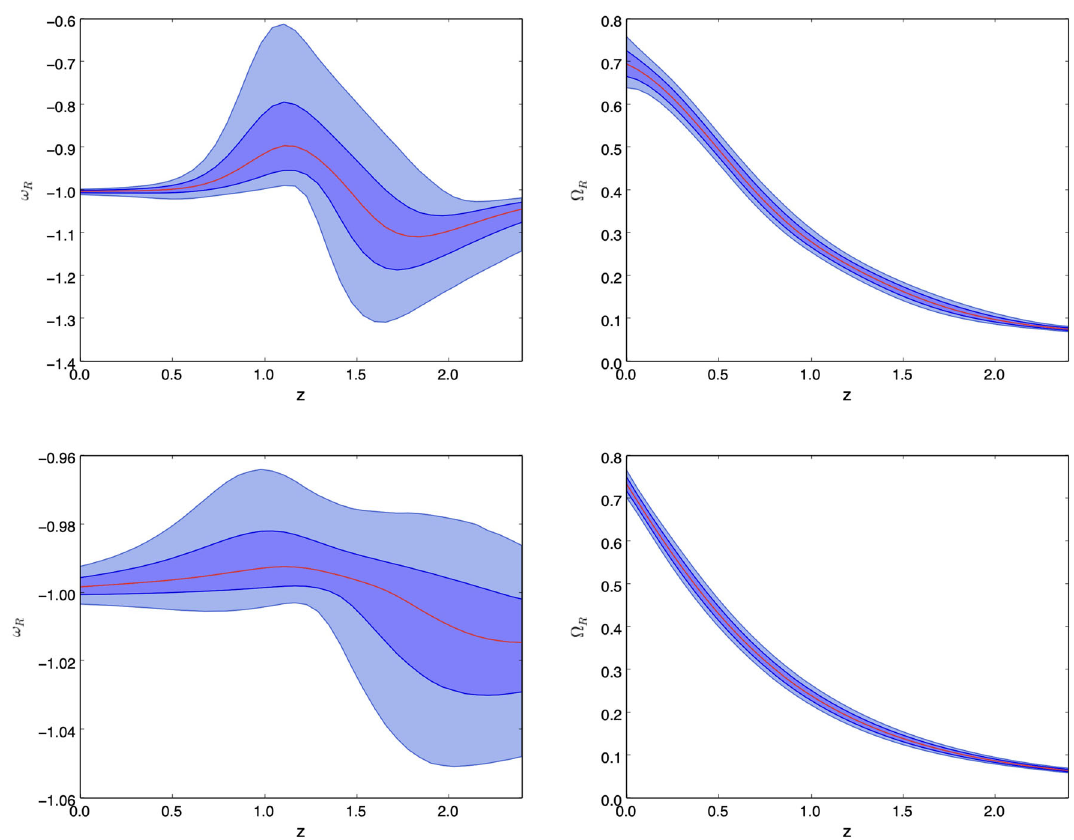
Fig. 1 The GP reconstruction of ω R and (cid:13) R , for the 30 H ( z ) sam- ples deduced from the differential age method with 10 additional sam- ples obtained from the radial BAO method (Table 1), is presented on the upper panel, when H 0 = 73 . 52 ± 1 . 62 km s − 1 Mpc − 1 has been merged to the expansion rate data used in the GP. The bot- tom panel corresponds to the GP reconstruction of ω R and (cid:13) R , when H 0 = 67 . 40 ± 0 . 5 km s − 1 Mpc − 1 has been merged to the expansion rate data used in the GP. The reconstruction is obtained for the f ( R ) model given by Eq. (18). The solid line is the mean of the reconstruc-